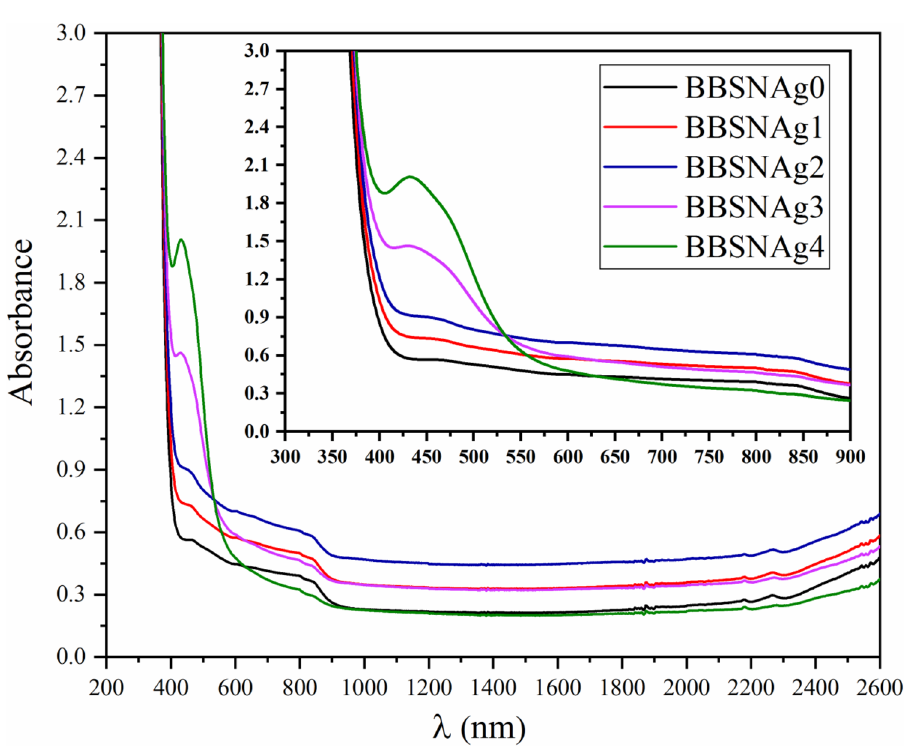
Figure 3. UV–visible absorption spectrum of glass samples doped with Ag 2